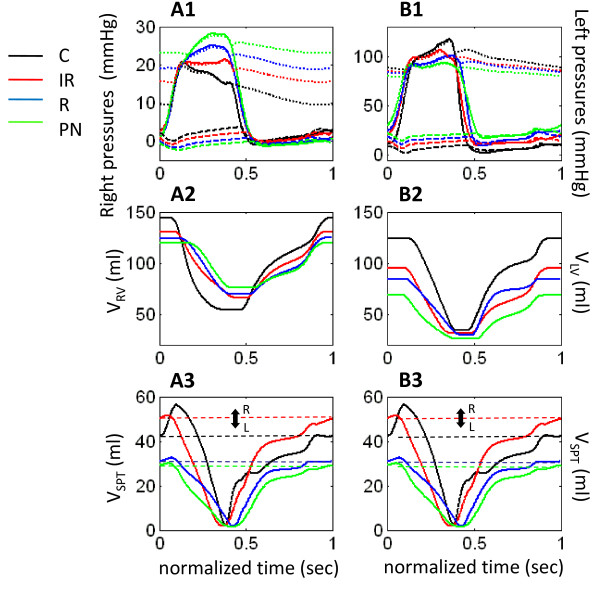
Time-Aligned Pressures and Volumes. Time-aligned ventricular and arterial pressures (Panels A1 and A2), chamber volumes (Panels B1 and B2) for the right and left hearts, and septal volume (Panels C1 and C2) in control and different cases of LVDD.